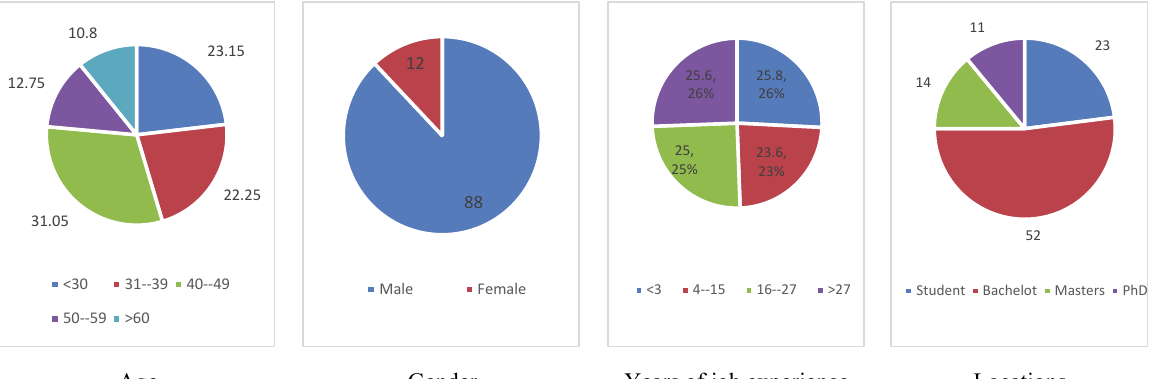
Fig. 2. Personal characteristics of the participants